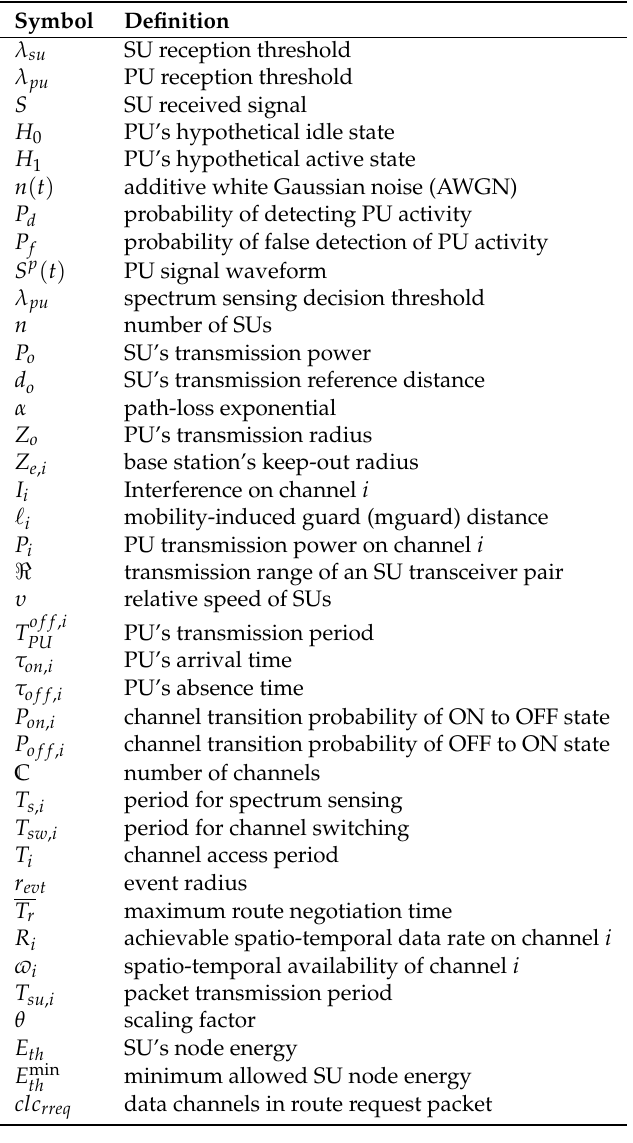
Table 1. Notations. PU, primary user; SU, secondary